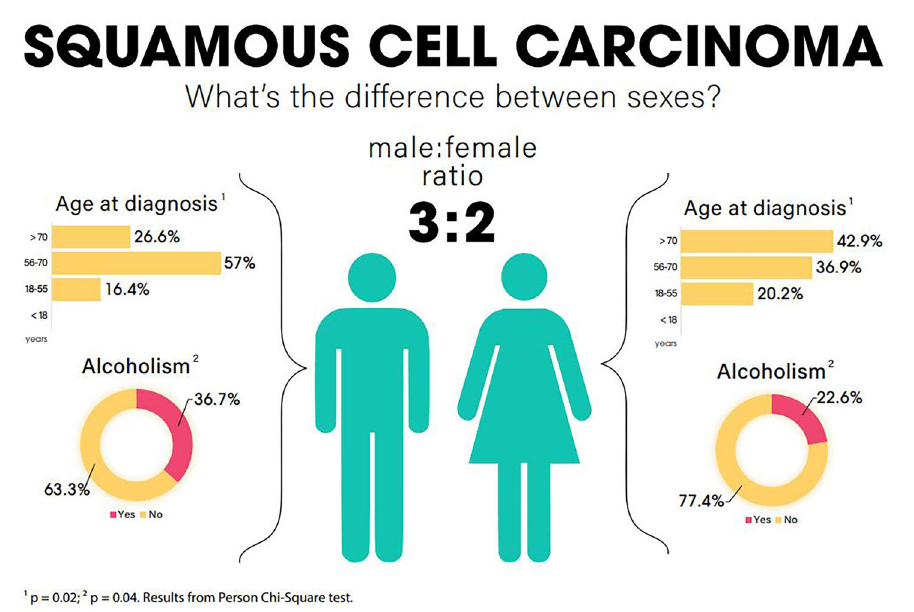
Figure 6. Sex differences for squamous cell carcinoma (SCC). Higher in males (ratio 3:2) and statistical differences in age a diagnosis (p = 0.02) and alcoholism (p = 0.04), UH Seidman Cancer Center Database